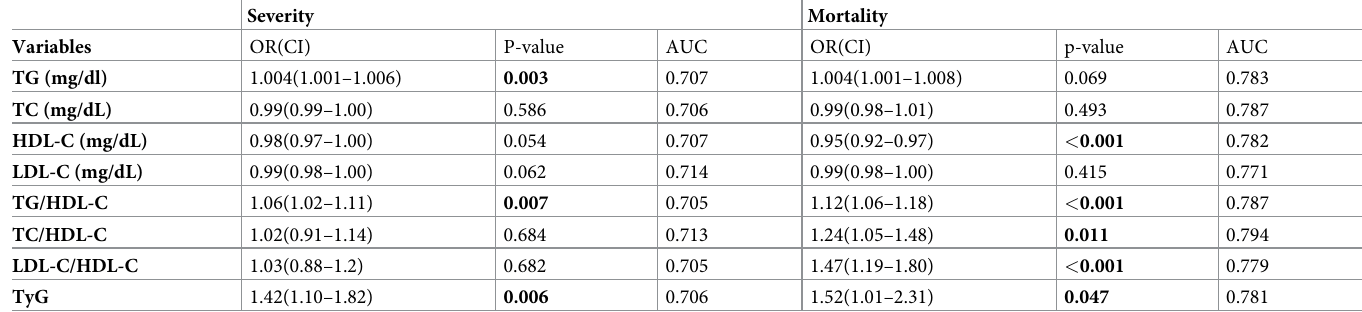
Table 3. Odds ratios for severe and deceased cases associated with lipid profile, TyG index, and lipid ratios.